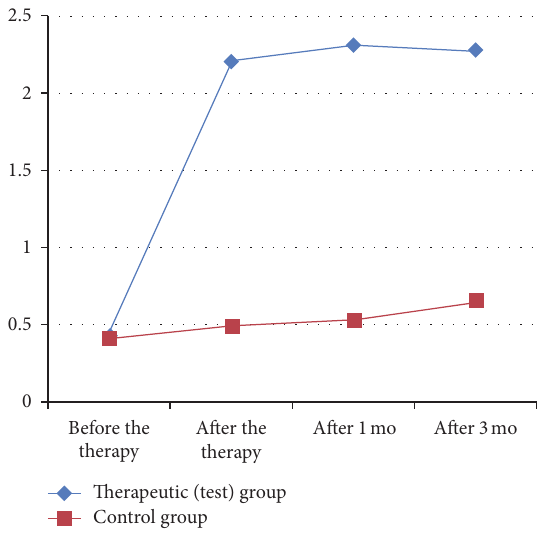
Figure3:Dynamicsofpainduringmovementinthetestandcontrol group [VAS].